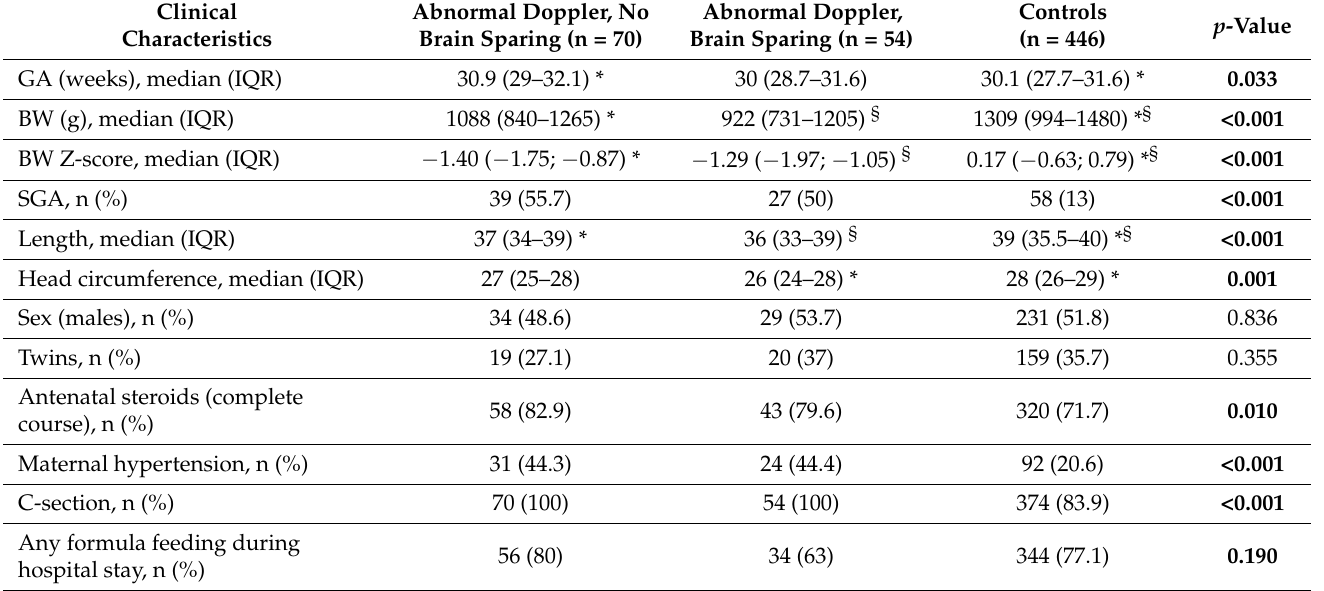
Table 4. Clinical characteristics in infants with abnormal antenatal Doppler with and without antena- tal evidence of brain sparing and controls. Significant between-group comparisons are highlighted in bold. Abbreviations: BW: birth weight; GA: gestational age; IQR: interquartile range; SGA: small